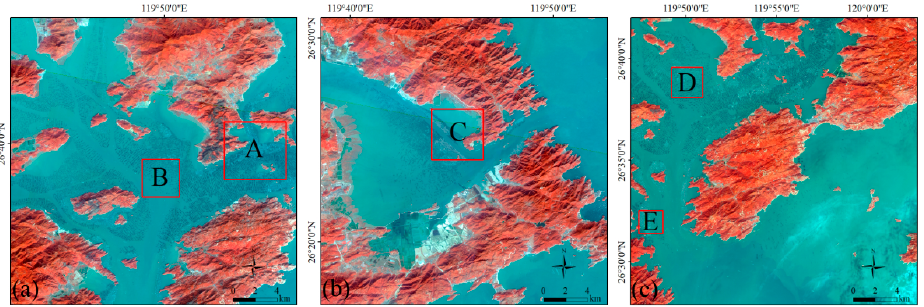
Figure 7. Training data (false color: band combination 421). ( a ) Training data A and B from November 2013. ( b ) Training data C from November 2013. ( c ) Training data D and E from November 2017.